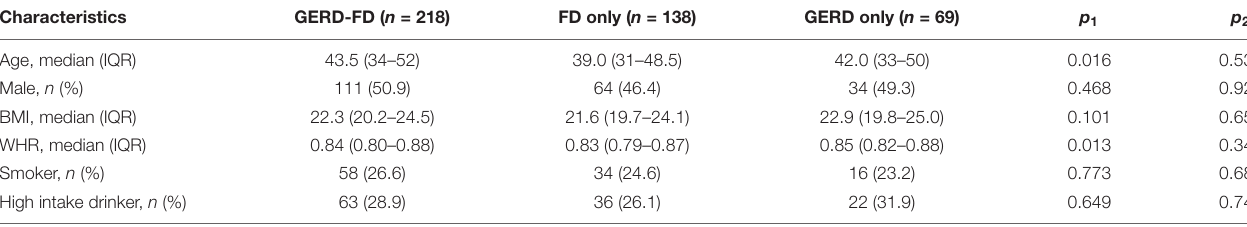
TABLE 4 | Characteristics of patients in the GERD-FD overlap, FD-only, and GERD-only groups. Characteristics